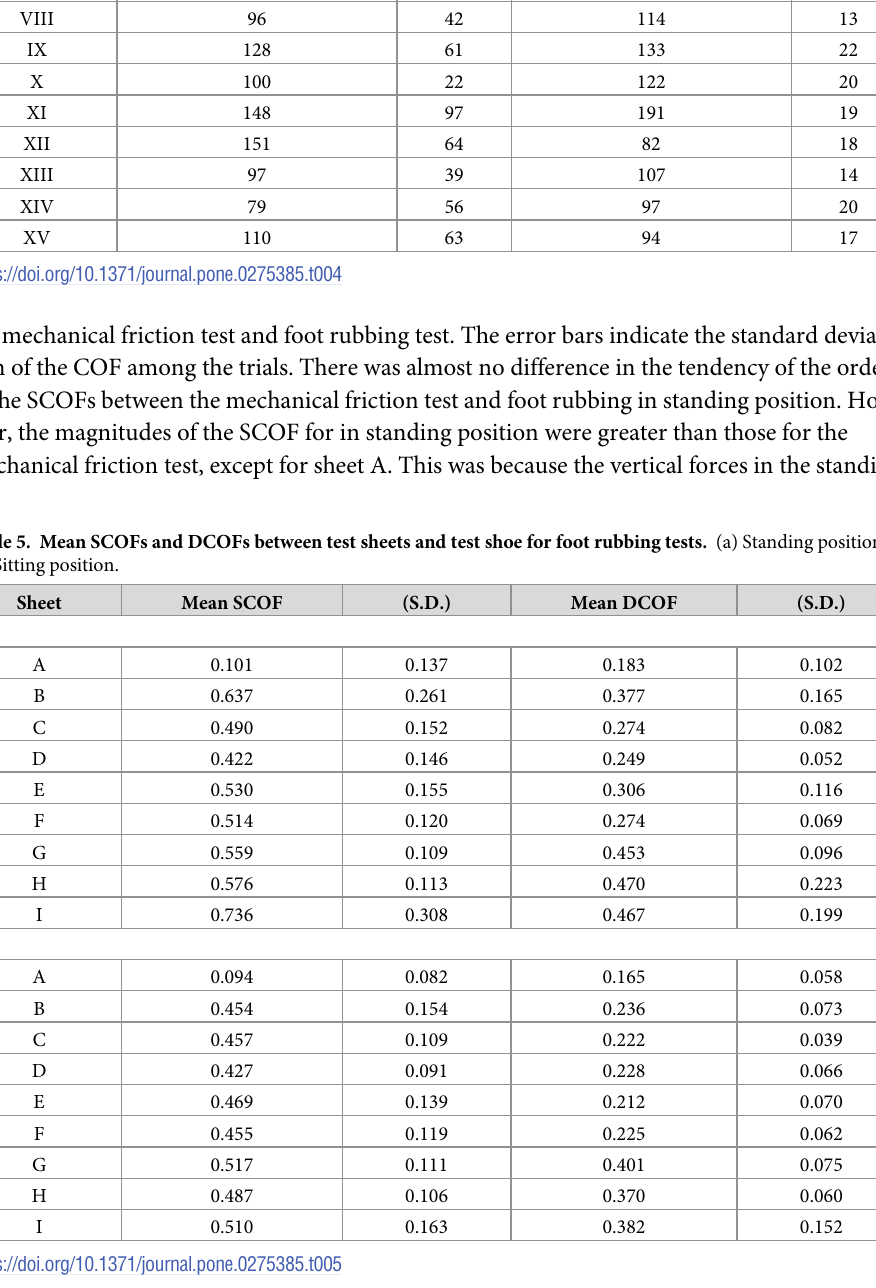
Table 4. Mean vertical forces at slip onset for each participant.